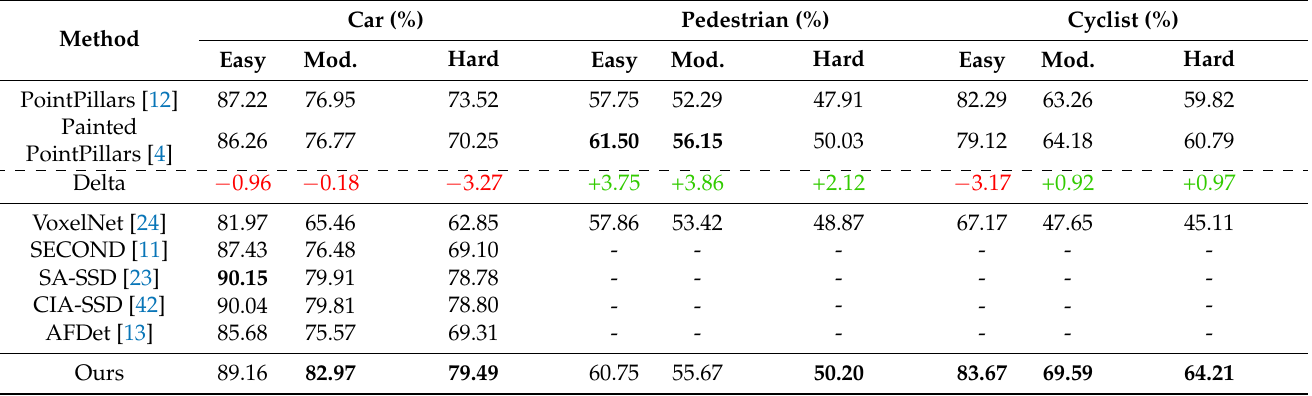
Table 5. The 3D detection AP of compared single-stage methods on the KITTI validation set. The AP is calculated with 11 recall points.